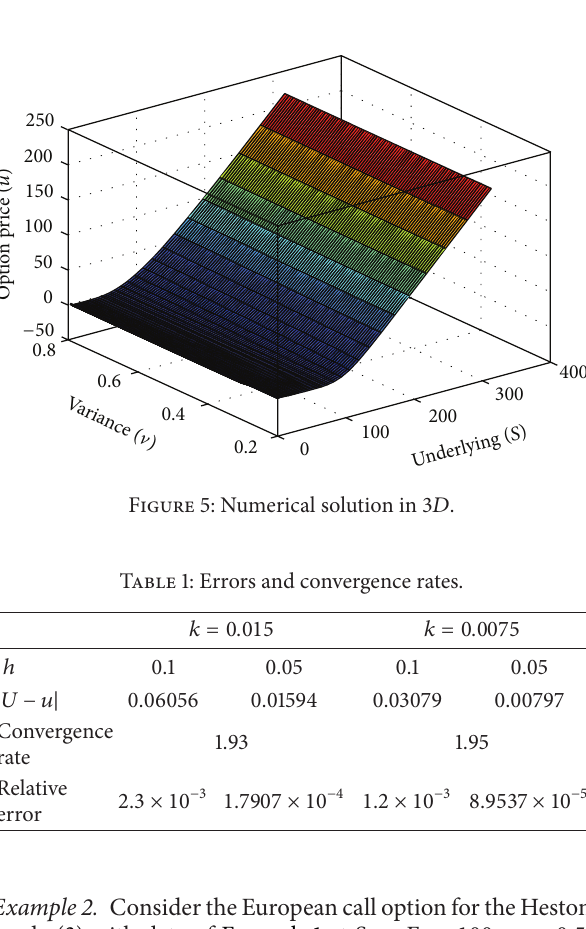
Figure 4: Breaking positivity and stability conditions.